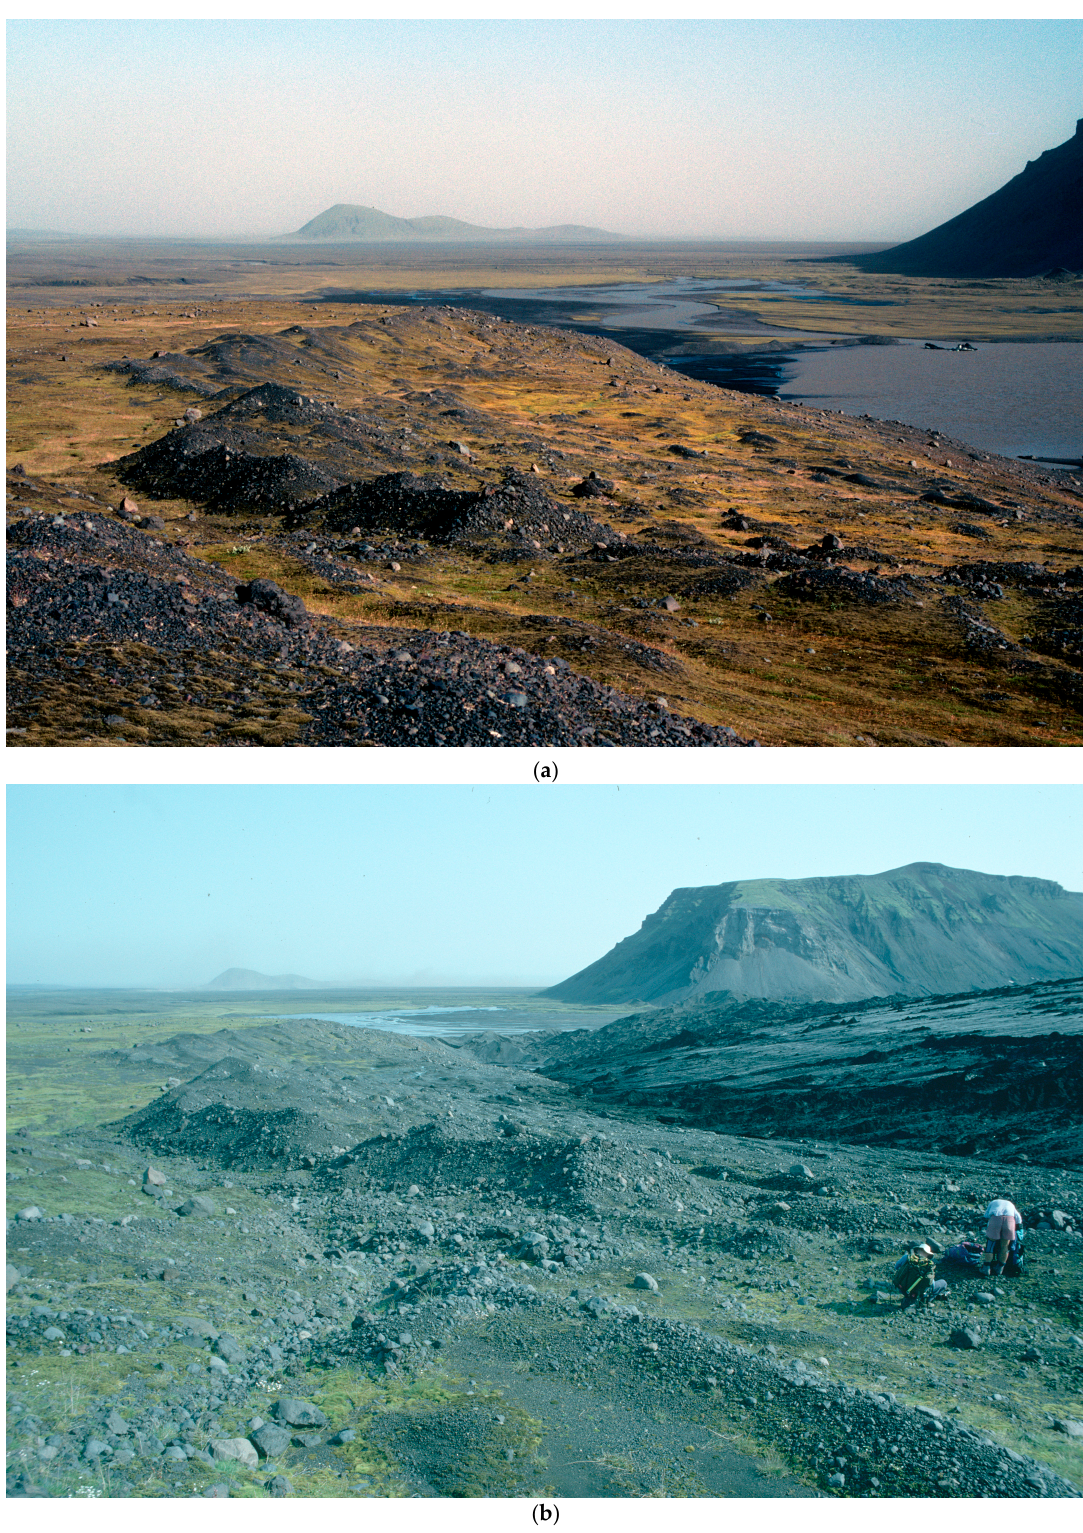
Figure 5. Ground photographs at the northern margin of Sandfellsjökull taken in 2007 ( a ) and 1994 ( b ), showing the significant reduction in the glacier surface and the 1990s push moraine complex in the middleground.